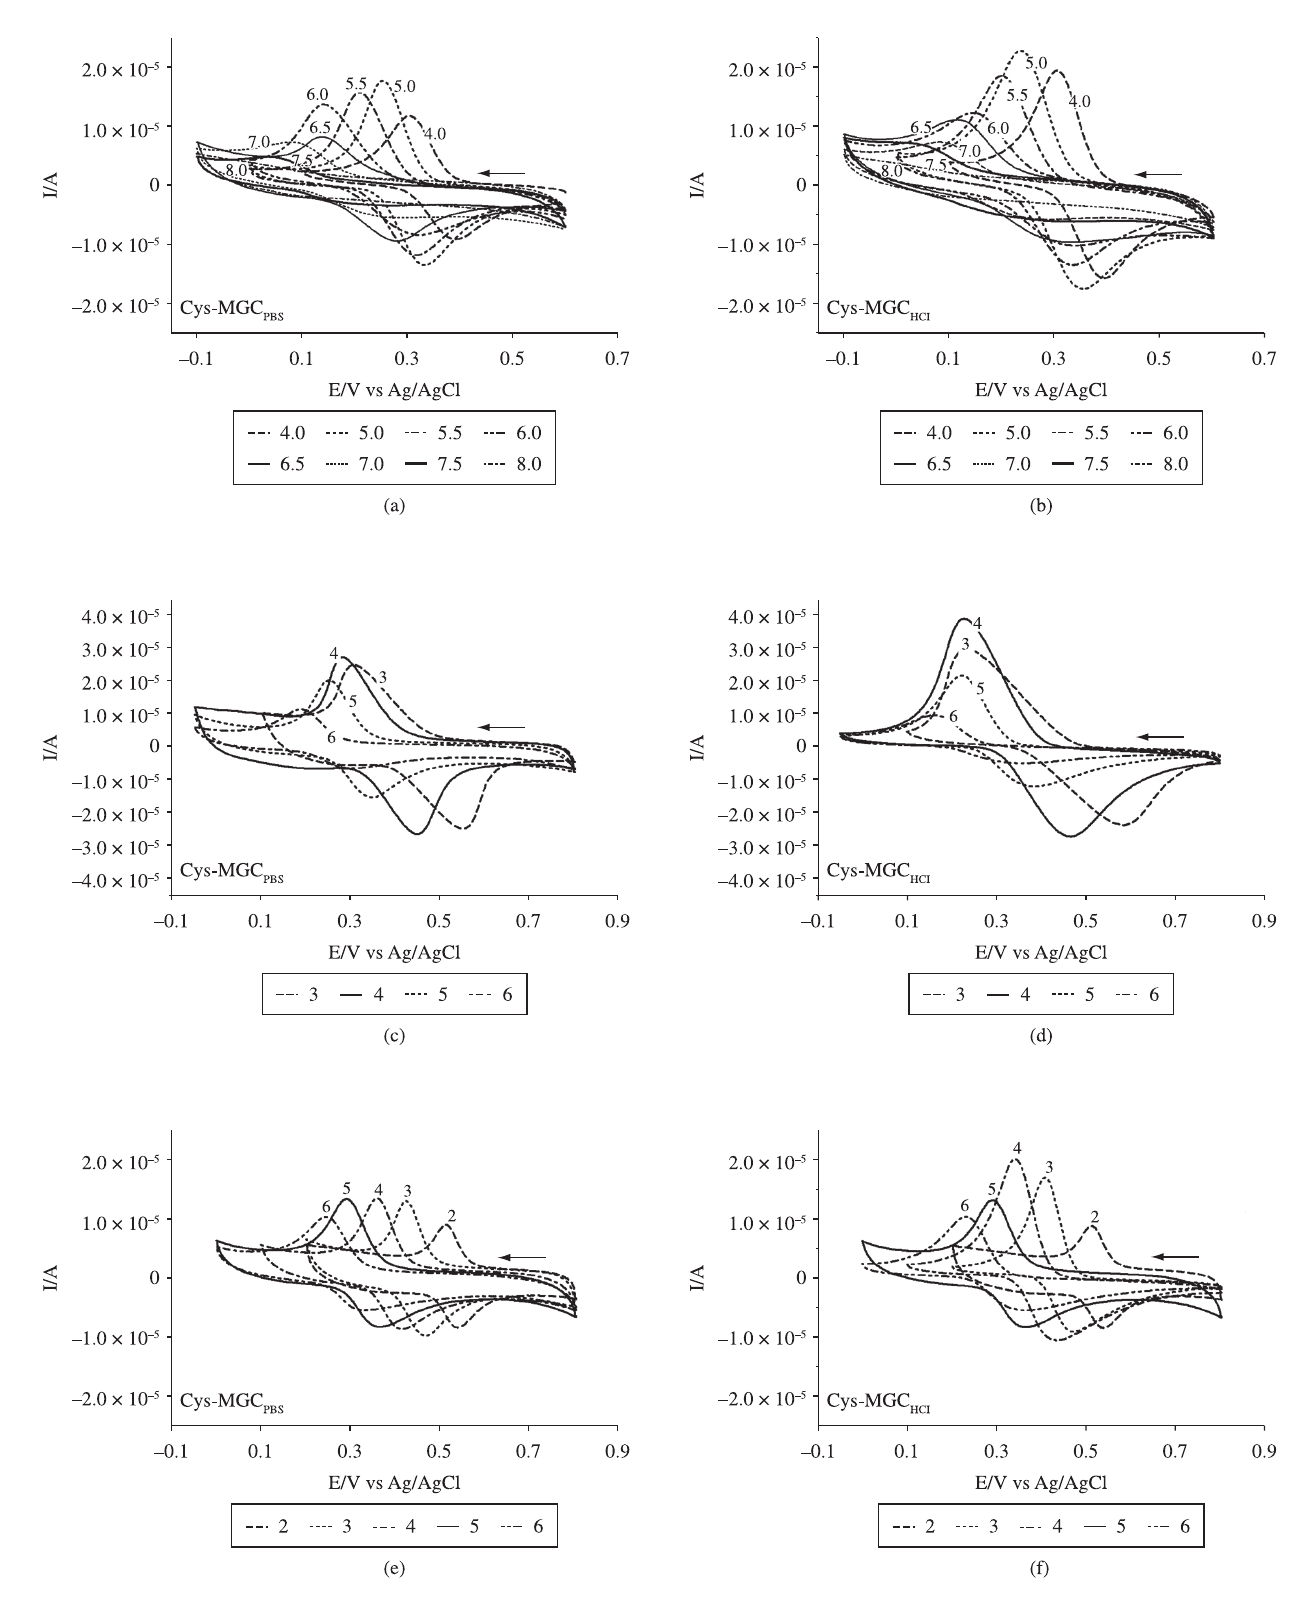
and Cys-MGC ) as a function of pH. Cyclic voltammograms of DA were PBS HCl